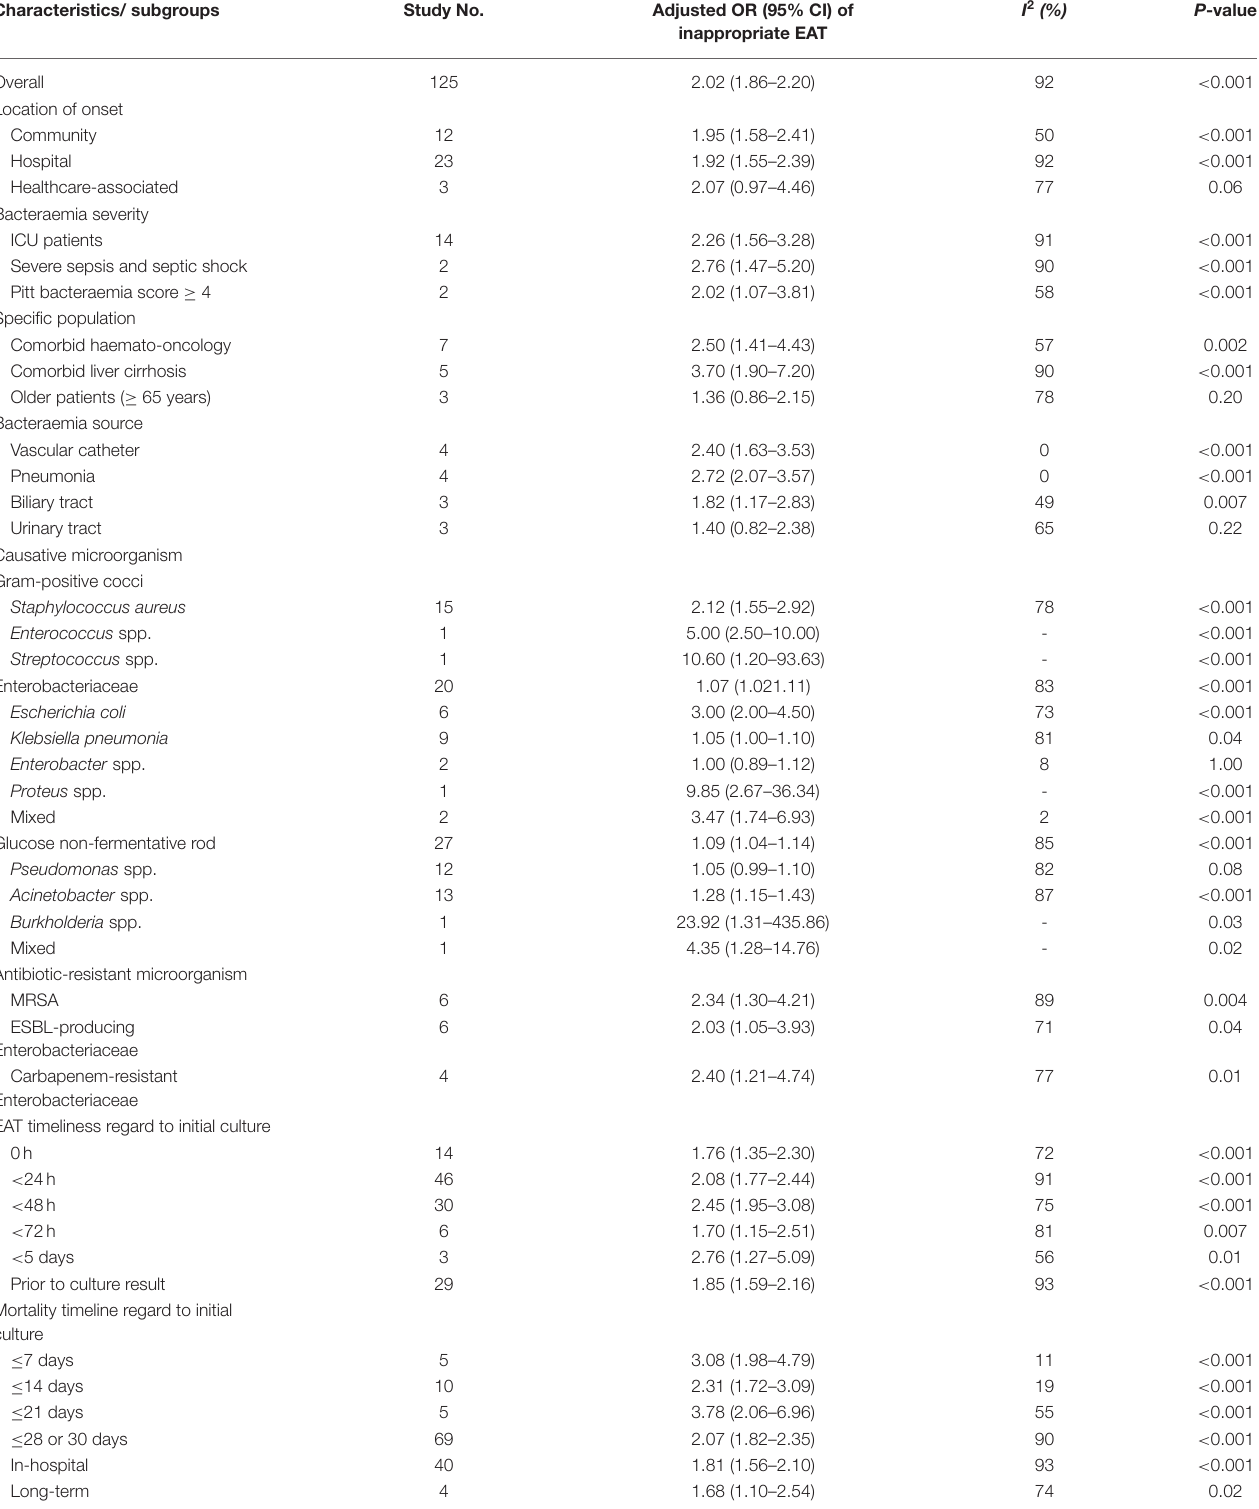
TABLE 2 | Adjusted analyses in overall and subgroup patients. Characteristics/ subgroups Study